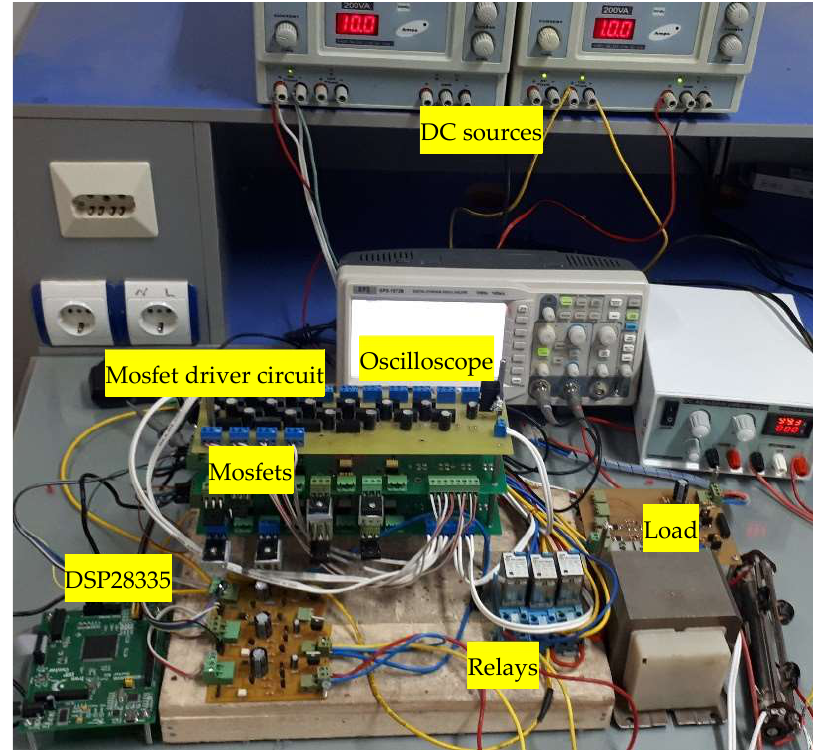
Figure 17. Laboratory Prototype.